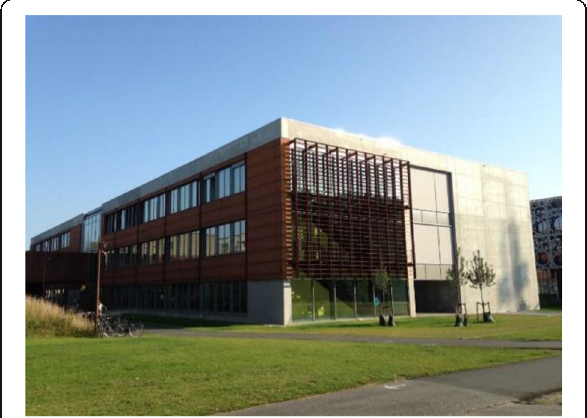
Fig. 1 (Abstract P10). Southwest view of the OU44 building located at the University of Southern Denmark Campus Odense.